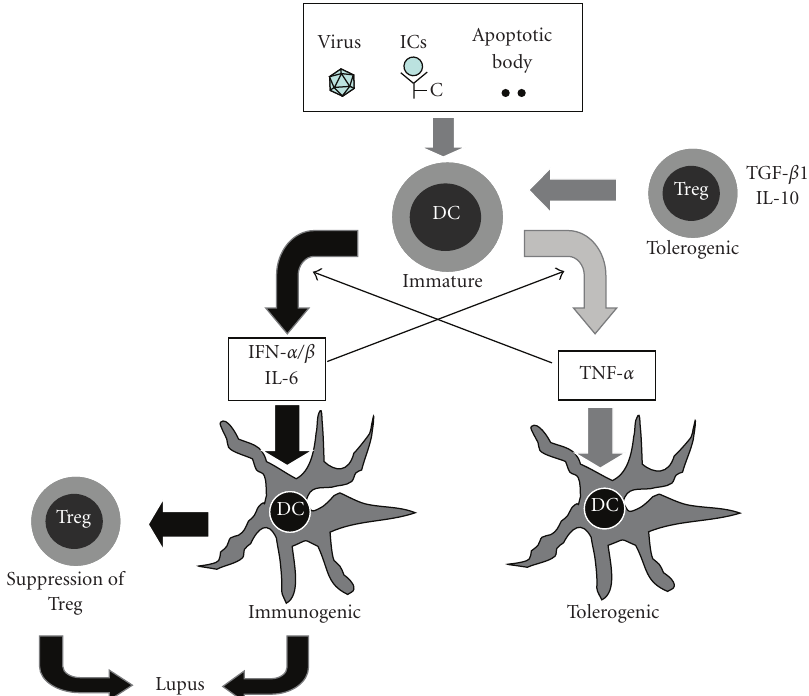
Figure 2: Notion of IFN- α/β and TNF- α axis balance proposed by Banchereau and Pascual [26]. Environmental factors (e.g., viral infections), apoptotic bodies and immune complexes stimulate pDCs through the coengagement of Fc γ R and TLRs trigger the production of IFN- α/β from pDCs and following production of TNF- α occurs. Also IFN- α/β induces the generation of mature DCs. Banchereau and Pascud hypothesize that increased production of TNF- α may weaken IFN- α/β production, leading to prevention of lupus. Also tolerogenic peptide activates Treg cells leading to production of TGF- β may inhibit DCs activity, resulting in the suppression of lupus development [27]. These events suppress the lupus development, whereas immunogenic DCs suppress function of Treg cells. Thus Horwitz [22] proposed T reg regulation together with tolerogenic DCs for therapy. Important cytokines are shown in bold arrows